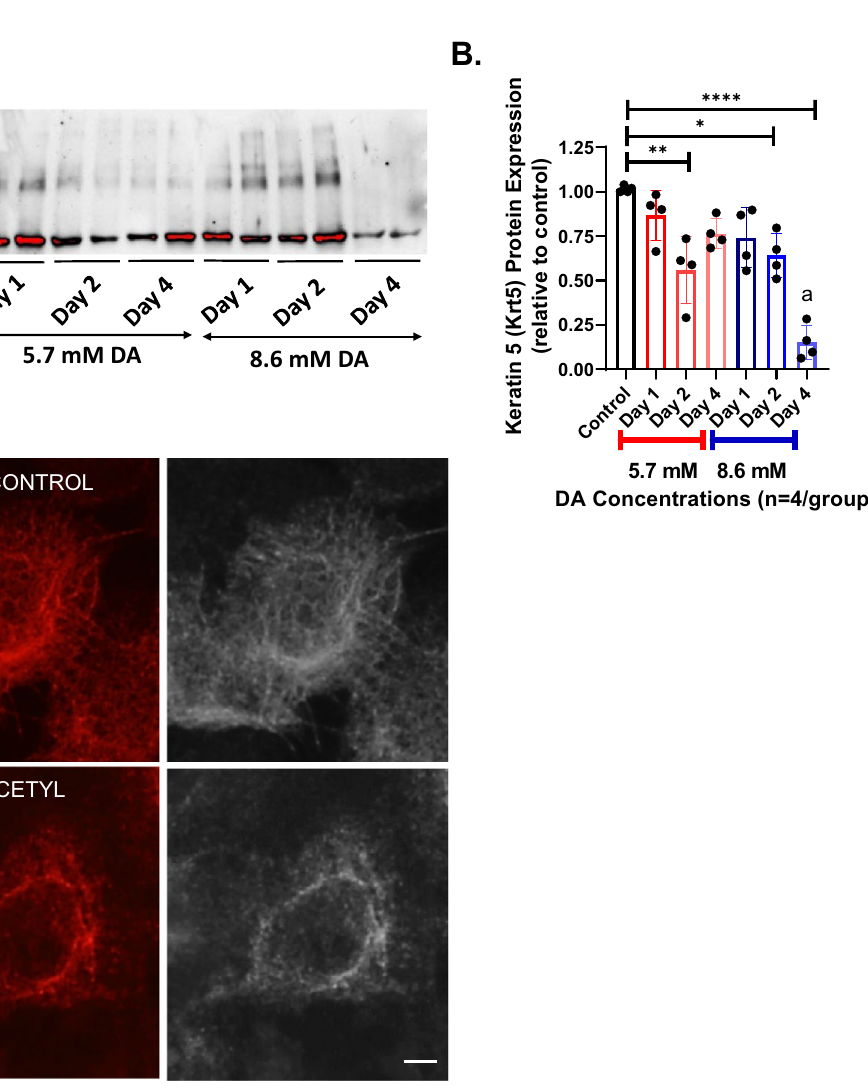
Figure 2. Diacetyl exposure induces keratin 5 crosslinking. ( A ) Representative western blot of keratin 5 (KRT5) from 16HBE culture homogenates at Days 1, 2 and 4 after DA exposure (5.7 and 8.6 mM). Known molecular weight of KRT5 is 58 kDa. Following DA exposure, KRT5 expression was also detected at 116 kDa. By Day 4 after DA exposure, higher molecular weight band dissipated. ( B ) Quantification of total lane KRT5 abundance normalized to lane total protein. Total KRT5 abundance decreased significantly at Day 2 in 5.7 mM and 8.6 mM DA-exposed cultures compared to controls (ANOVA; **p < 0.01 and *p < 0.05, respectively; n = 4/group). At Day 4, KRT5 abundance remained significantly lower than controls (ANOVA; ****p < 0.0001). ( C ) Representative immunocytochemistry images of KRT5 in control cells (top) and cells exposed to 8.6 mM DA (bottom) (scale bar: 10 μm). Images obtained at Day 2 after DA exposure. In control cells, the intermediate filaments stained by KRT5 extend toward the periphery. In DA-exposed cells, KRT5 intermediate filaments aggregate near the